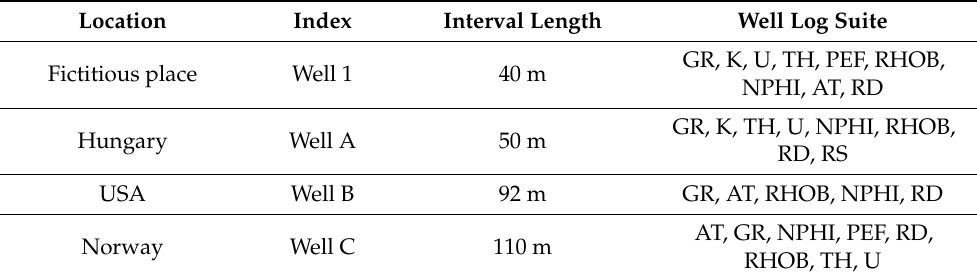
Table 1. Well logging data summary of the analyzed wells.